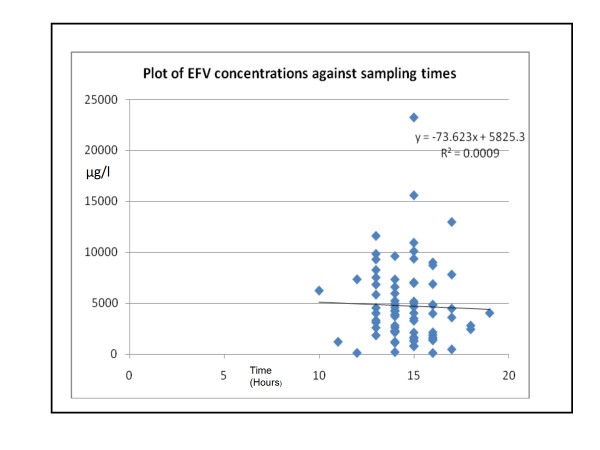
Plot of EFV plasma concentrations against sampling times. R2 value of 0.0009 indicates no correlation between sampling times and EFV plasma concentrations of patients involved in the study.